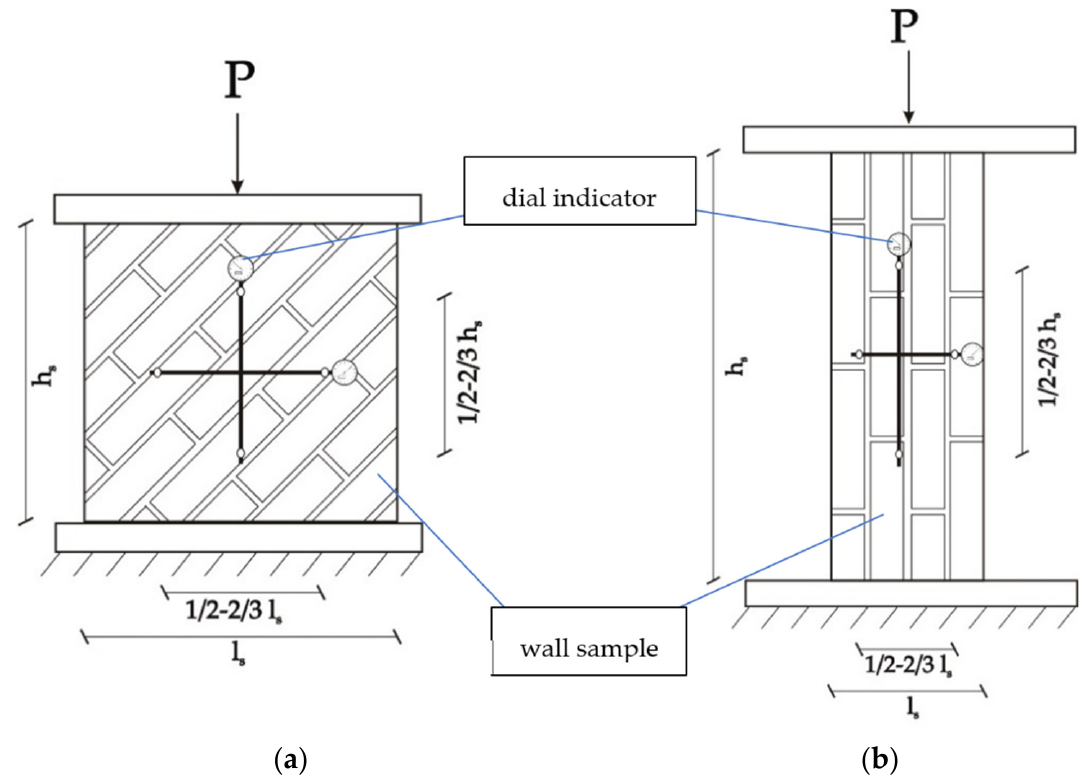
Figure 6. Compressive strength test with dial indicator installation, h s —height of the sample, l s —length of the sample ( a ) θ = 45°, ( b ) θ = 90°.